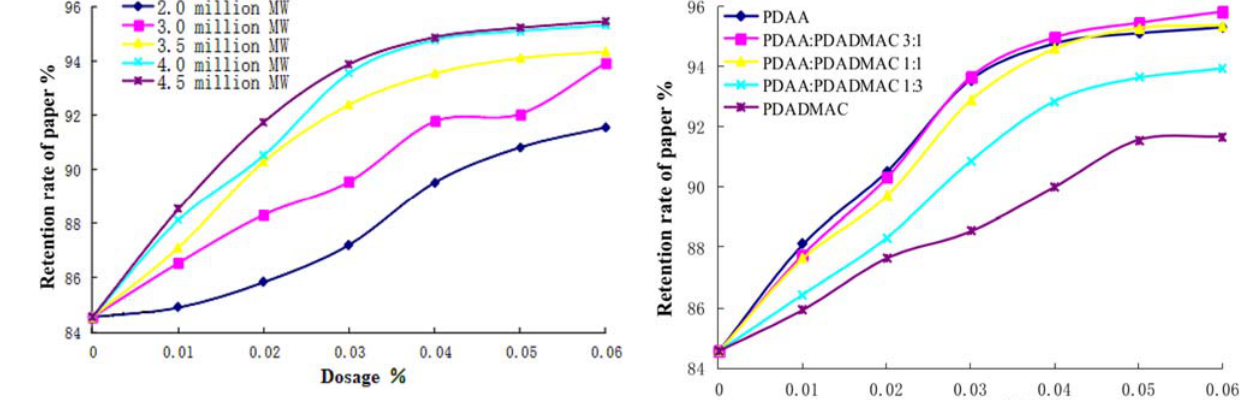
Figure 6: E ff ect of molecular weight on retention properties. The cationic degree of PDAA is 25 wt% based on the total weight of monomer.